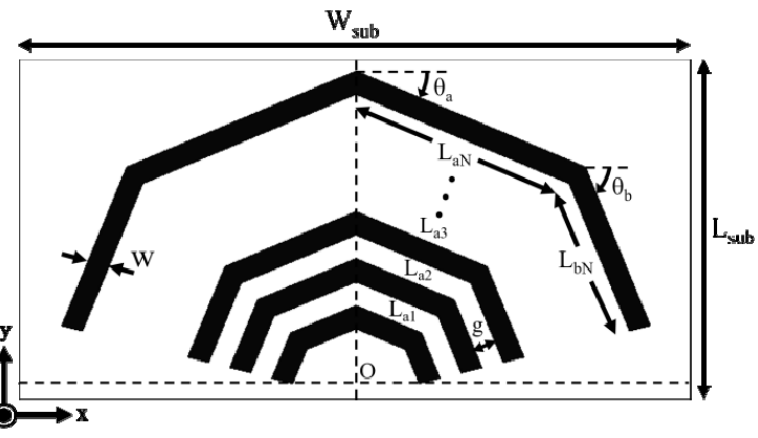
Figure 1. Geometrical configuration of the proposed tag.